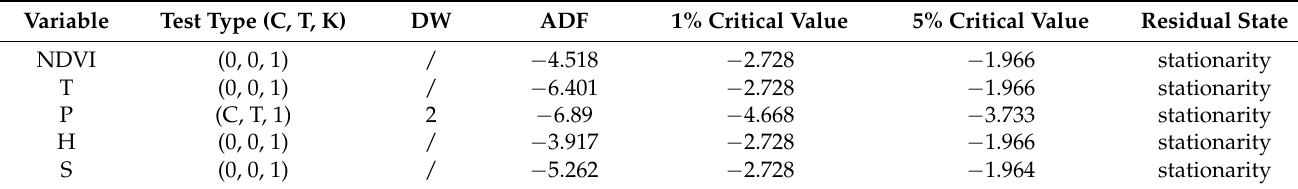
Figure 2. Annual and monthly variation in NDVI in the middle reaches of the Yangtze River (MRYR). ( a ) interannual variation of NDVI; ( b ) monthly variation of NDVI. Table 1. Co-integration analysis of the annual mean of variables from 1999 to 2015.